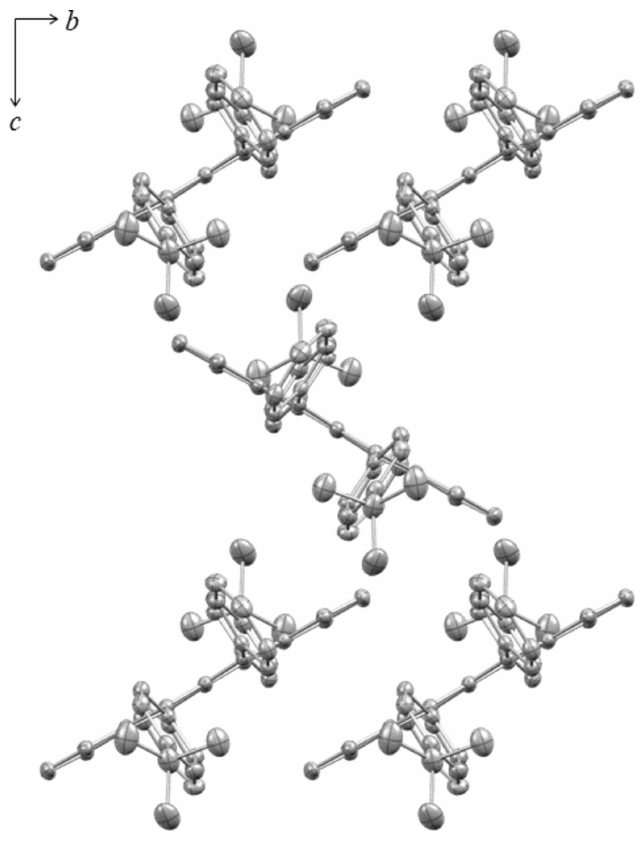
Figure 4 Crystal projection of 2 displaying herringbone